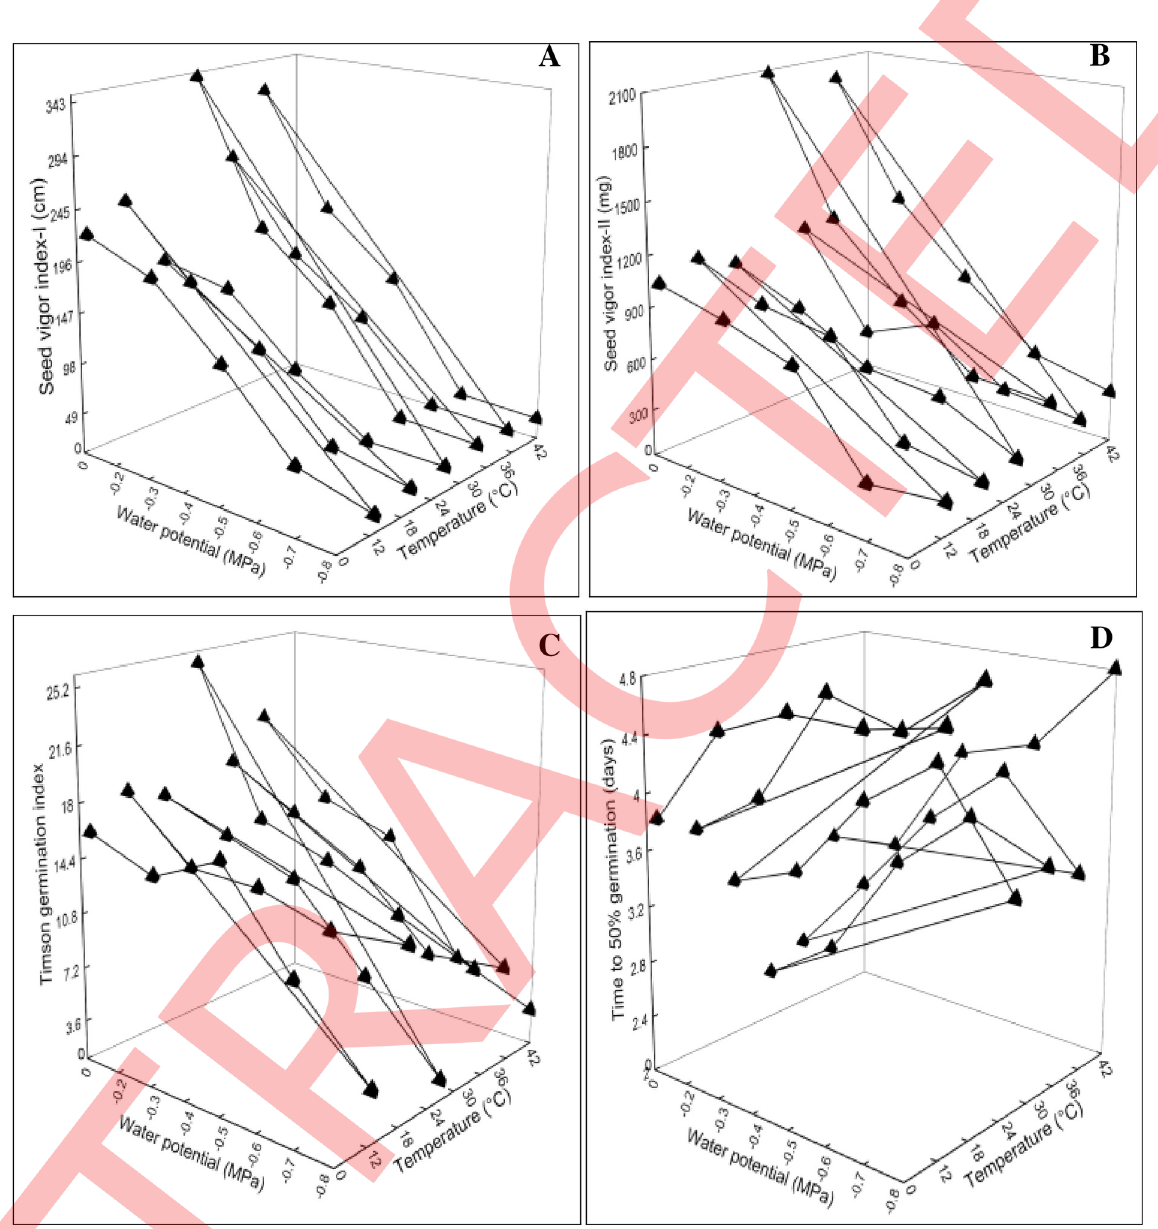
Fig 4. Interactive effect of water potential and temperature on ( A ) Seed vigor index-I ( B ) Seed vigor index-II ( C ) Timson germination index ( D ) Time to 50% germination of chickpea var. NIFA 1995.